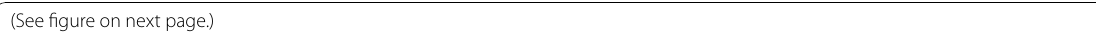
(See figure on next page.) Fig. 11 A Locality map of the Litten-Chreialp section and photographs of Altmann Member ( B – F ) and of the Drusberg Member ( G ). B View of the pinching glauconitic unit. C Other view of the Altmann Member and its two subunits. D Focus on the glauconitic facies from the base of the “Drusberg-like” unit. E View of the “Drusberg-like” unit. F Focus on the upper phosphatic conglomerate. G View of the uppermost marly interval of the Drusberg Member passing upward to the Schrattenkalk